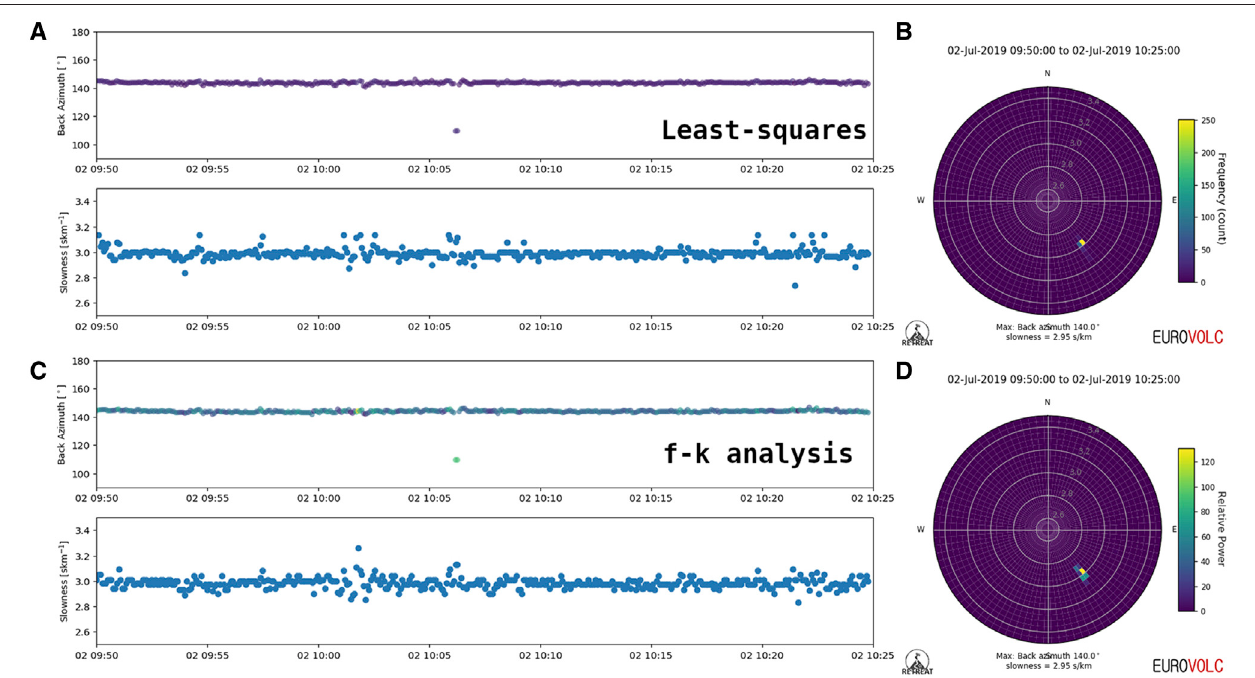
FIGURE 8 | Comparison of RETREAT applied to infrasonic array data using two different beamforming methods. (A) Timeseries of backazimuth and slowness values derived using Least-Squares inversion and (B) corresponding histogram of slowness and backazimuth values in polar form. Note that this is weighted by the MCCM (mean cross-correlation maxima) rather than the relative power as in the f-k case. (C) Timeseries of backazimuth and slowness values derived using f-k analysis and (D) the corresponding histogram of slowness and backazimuth values in polar form, weighted by the relative power.